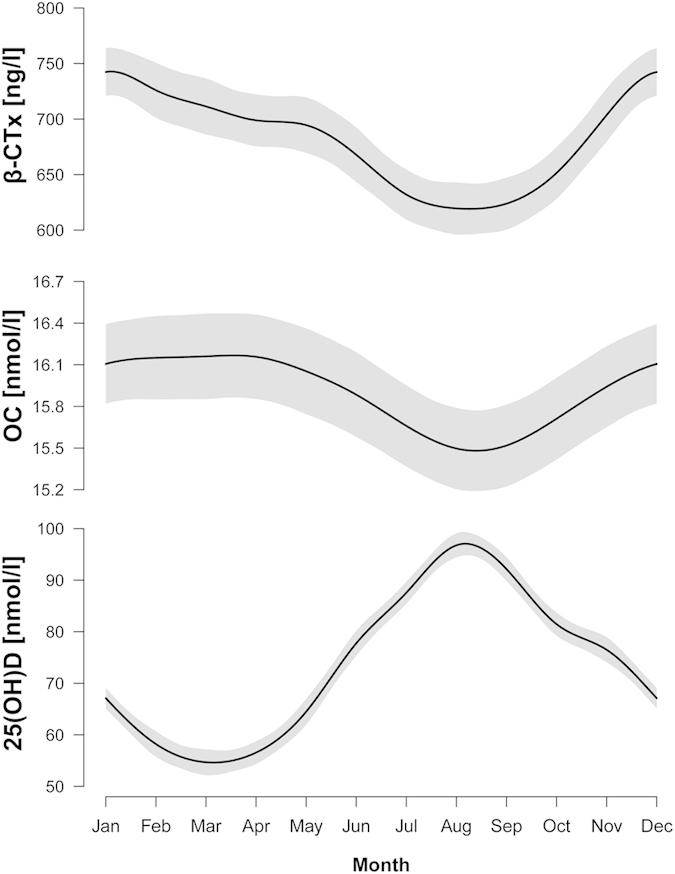
Seasonal mean estimated using generalized additive modeling adjusted for BMI, age, fasting status, time of blood drawn.Point wise confidence intervals shaded in grey.